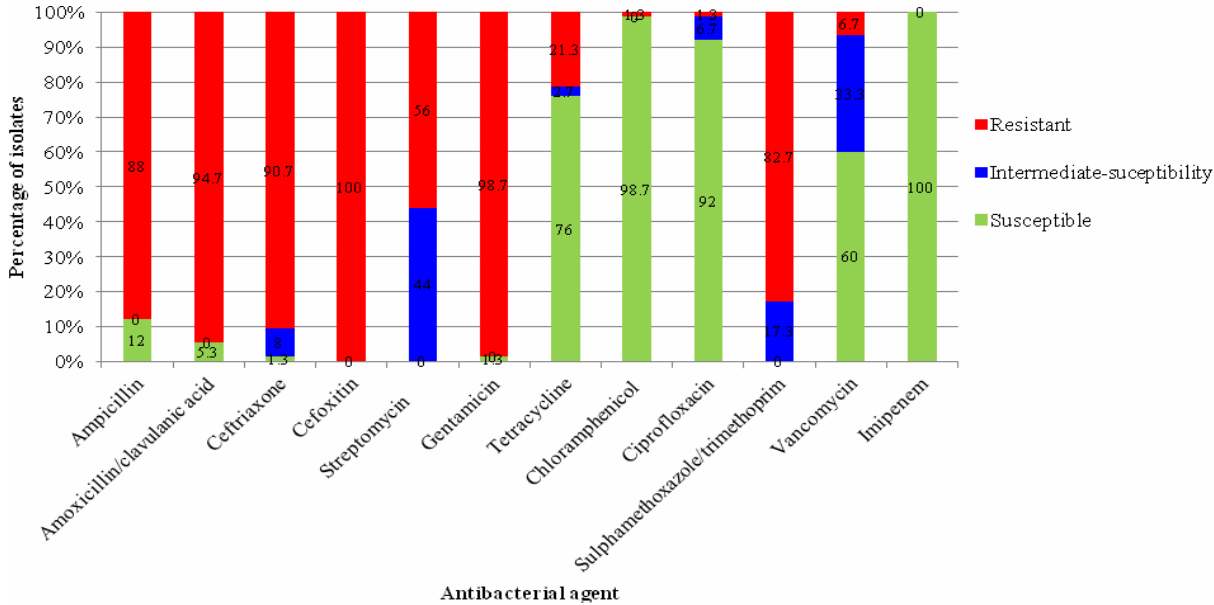
Fig. 2. Antibiogram of 75 enterococcal isolates from healthy beef